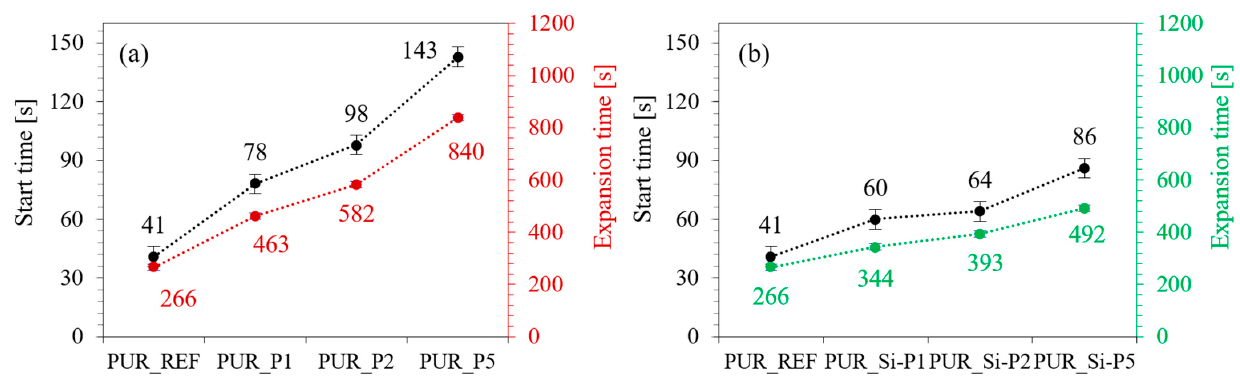
Figure 4. Results of the start time and expansion time of polyurethane foams with the addition of ( a ) unmodified plum filler ( b ) silanized plum filler.